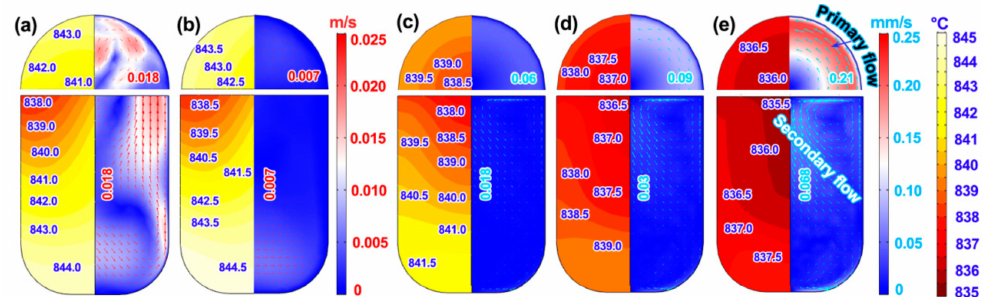
Figure 2. Simulation results of temperature field (left side) and flow field (right side) with di ff erent conditions: ( a ) without rotating magnetic field (RMF); ( b ) 600 mT static magnetic field (SMF); ( c ) 5 mT RMF; ( d ) 15 mT RMF and ( e ) 25 mT